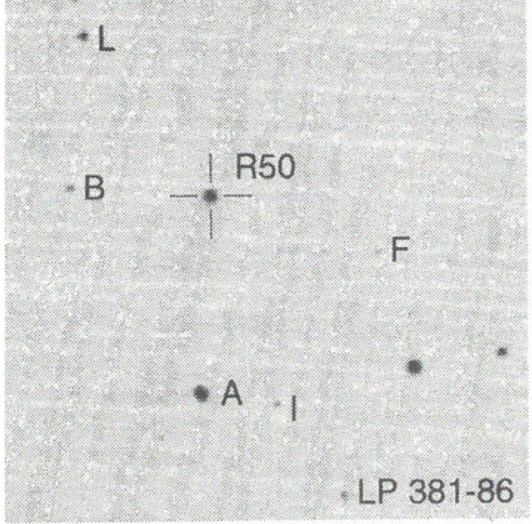
Fig. 1. Finding chart for G 166-37 = R 50. LP 381-86 is indicated.